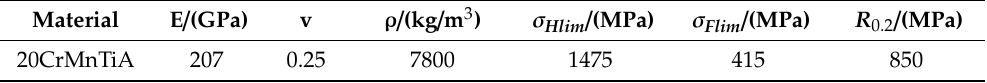
Table 2. Material properties of